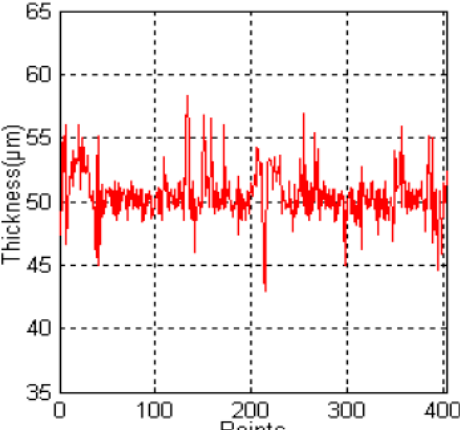
Figure 15. The Paint thickness Curve Spray painting along the V-direction Path.